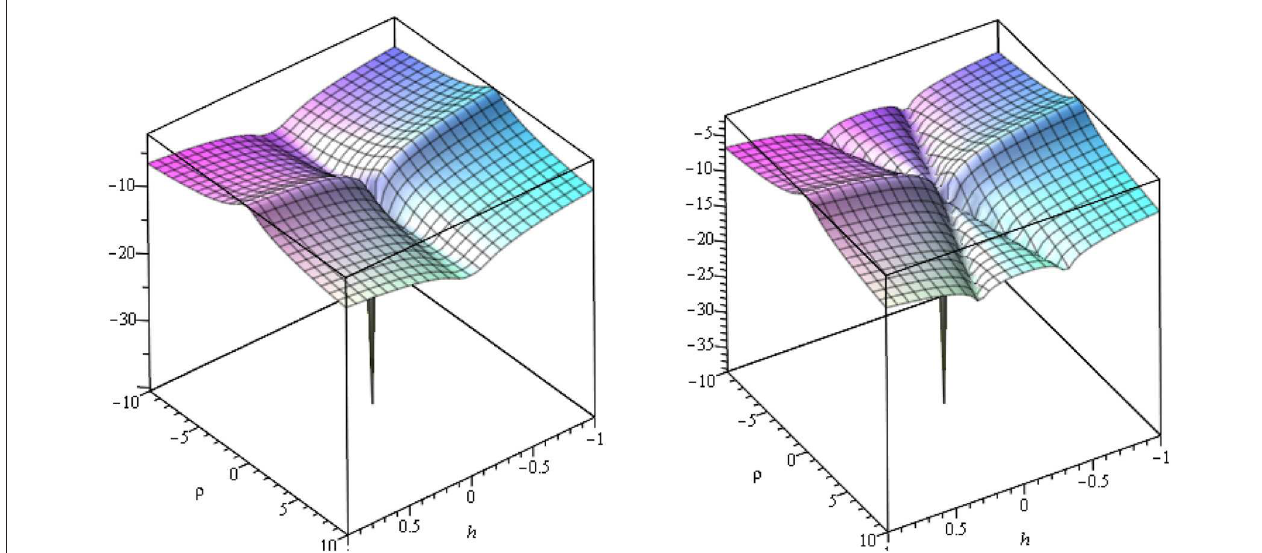
ξ σ ), as a function of h and ρ , all in units of M P , supporting, for λ H σ > 0, pure Hidden FIGURE 3 | Decadic log of the scalar potential (4) in the Einstein frame ( ξ H ≪ Scalar Inflation (HSI) (left) , and, for λ H σ < 0, Higgs-Hidden Scalar Inflation (HHSI) (right) [taken and used with permission from Ballesteros et al. (2017b)]. Inflation proceeds along one of the valleys. The couplings have been chosen such that the amplitude of primordial scalar perturbation is properly